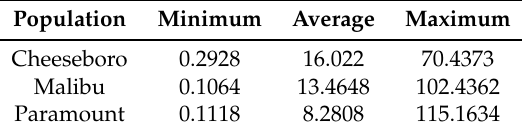
Table 1. Distance band in meters from neighbor count for the three